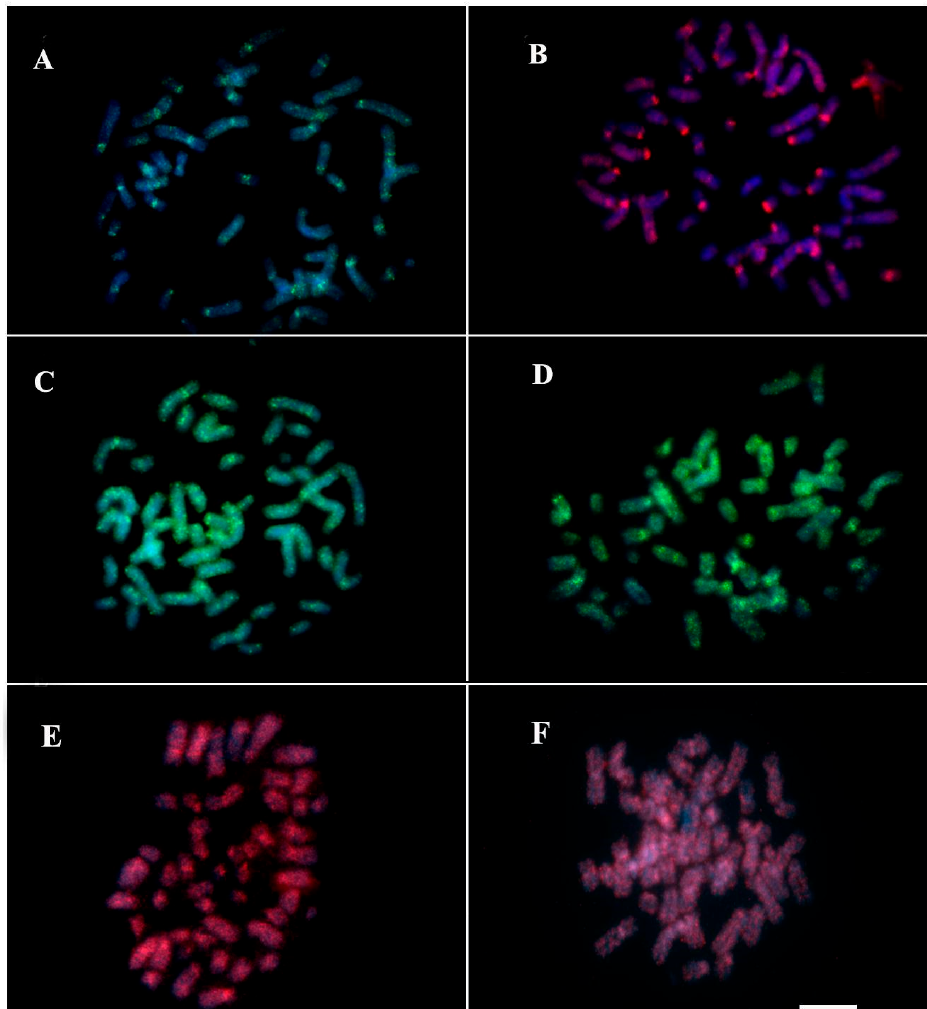
Figure 5. Chromosomal mapping of the transposable element LINE-1: ( A ) T. inunguis ; ( B ) T. m. manatus ; the insert indicates the pair 1 chromosome with a LINE-1 pattern similar to bands and compared to the pattern of G bands; and ( C ) “Poque”. Arrows indicate chromosomal regions in TIN and TMM karyotypes with low LINE-1 concentration. Bar 10 μ m.